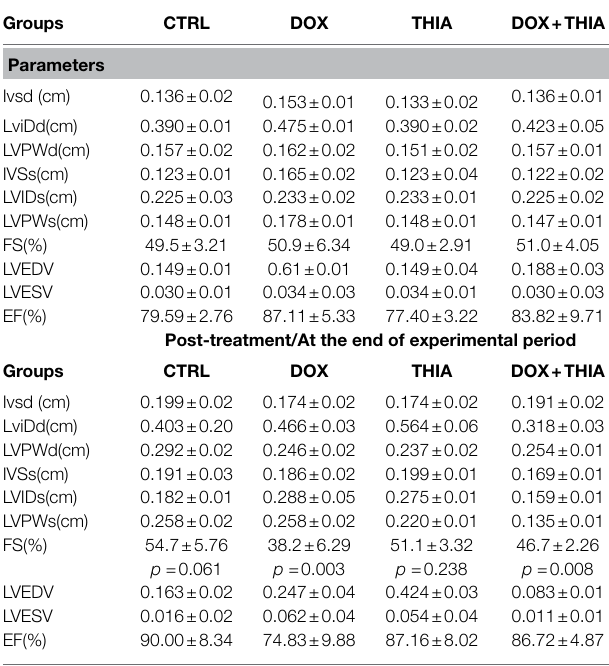
TABLE 1 | Echocardiographic parameters of left ventricular function before and after treatment in all groups. Pre-treatment/At the beginning of experimental period Groups CTRL DOX THIA DOX + THIA